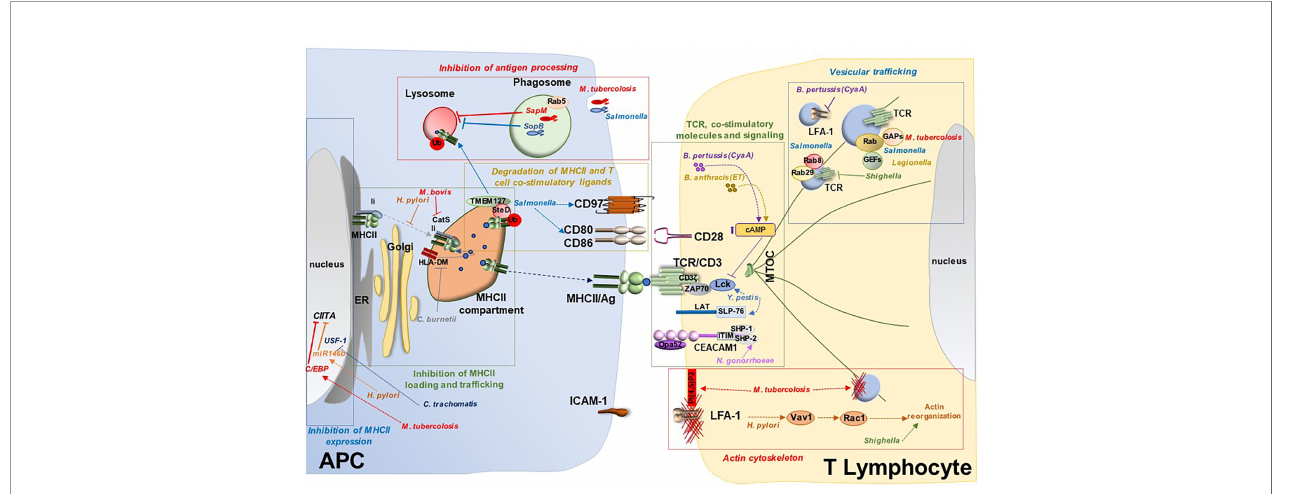
FIGURE 2 | Bacterial targeting of the immunological synapse. Model for suppression of IS assembly by bacterial pathogens. Bacterial pathogens exploit a variety of virulence factors to interfere with IS assembly at different steps, both at the APC side and at the T cell side. Bacteria target APCs and hence indirectly IS assembly by interfering with different mechanisms: i) MHCII inhibition through modulation of transcription factors responsible for its expression (e.g. CIITA regulation by M. tuberculosis, Helicobacter pylori and Chlamydia trachomatis ); ii) inhibition of antigen processing through suppression of phagolysosomal fusion (e.g. M. tuberculosis and Salmonella) ; iii) defective antigen processing and loading onto MHCII in the MHCII compartment (e.g. inhibition of the Ii-dependent pathway by Helicobacter pylori or targeting CatS and HLA-DM by M. tuberculosis and Coxiella burnetii , respectively); iv) degradation of MHCII and T cell co-stimulatory ligands such as CD80/CD86 and CD97 (e.g. Salmonella ). Bacteria interfere directly with IS assembly at the T lymphocyte side by i) targeting expression and function of the TCR and co-stimulatory molecules (e.g. CD3 z degradation by M. tuberculosis , CEACAM1 disabling by Neisseria gonorrhoeae or impairment of TCR signaling by Yersinia pestis, Bordetella pertussis and Bacillus anthracis ); ii) subverting the actin cytoskeleton (e.g. Shigella fl exneri , Yersinia pestis and Salmonella enterica serovar Typhimurium) ; and iii) interfering with vesicular traf fi cking by modulating Rab GTPases (e.g. Salmonella enterica , Legionella pneumophila , Shigella , M. tuberculosis ) or by targeting receptor traf fi cking (e.g the TCR by Shigella or LFA-1 by Bordetella pertussis